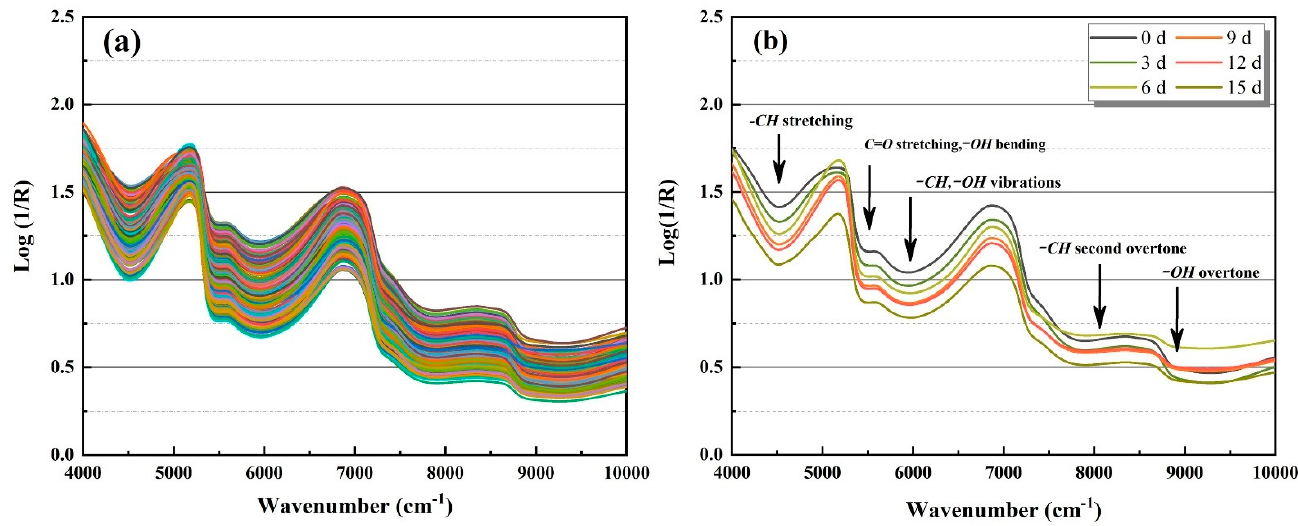
Figure 3. Relative reflectance spectra of mini-Chinese cabbage in nanopacking obtained using FT-NIR from 4000 to 10,000 cm − 1 . (( a ) Individual sample; and ( b ) mean spectra during each storage period).